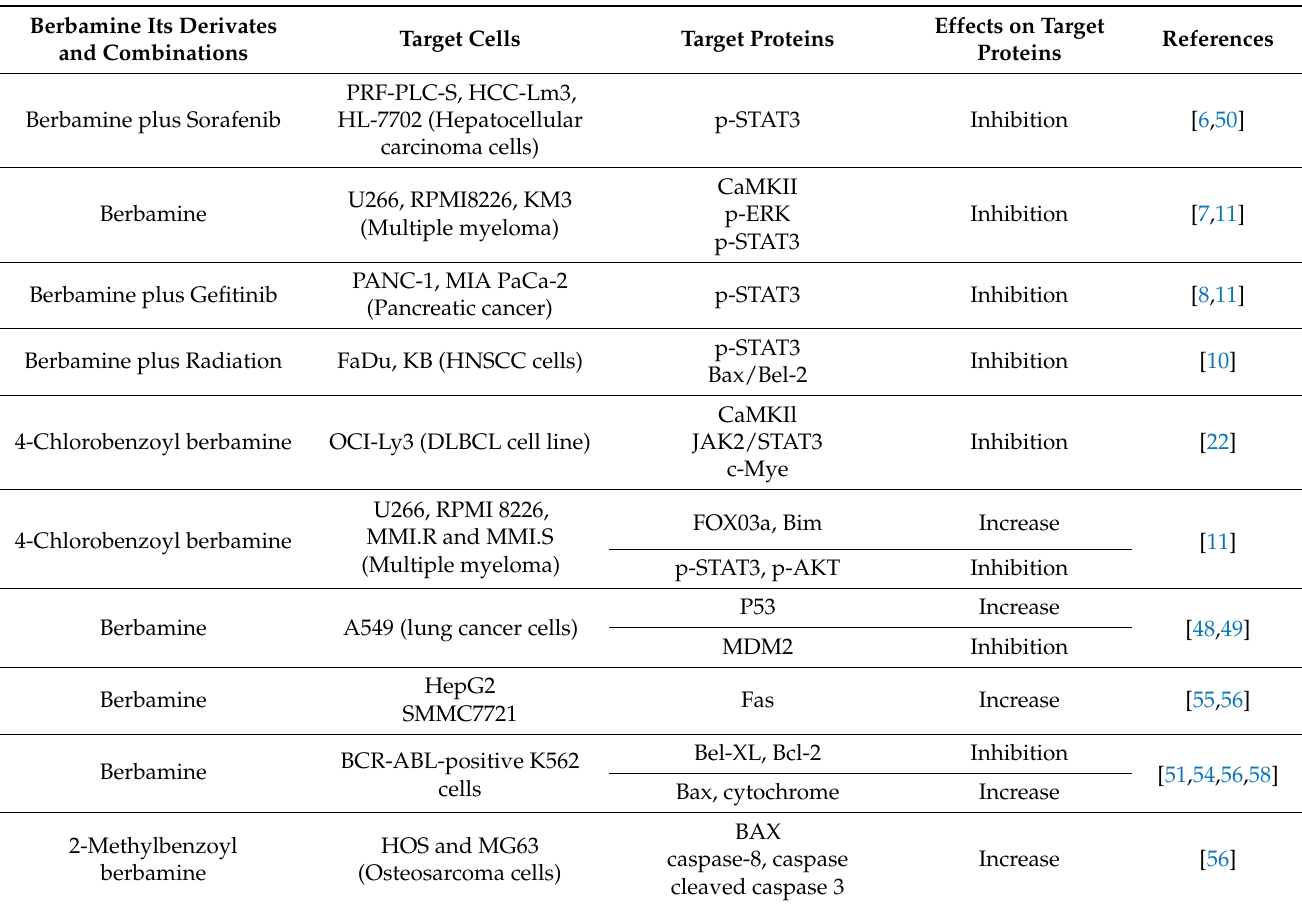
Table 1. Pharmacological targets of